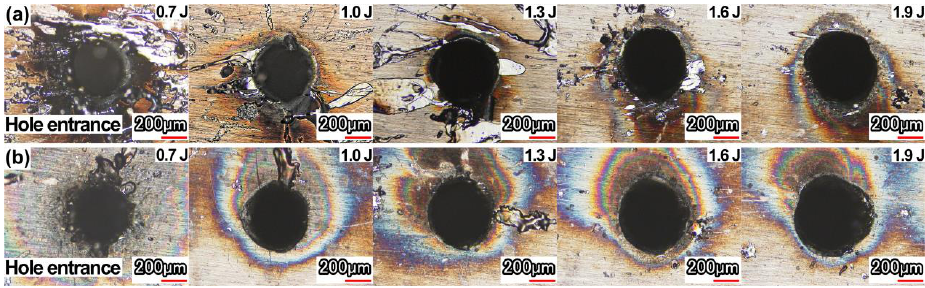
Figure 4. Effect of pulse energy on spatter around the hole entrance: ( a ) in air, ( b ) water-based assistance.